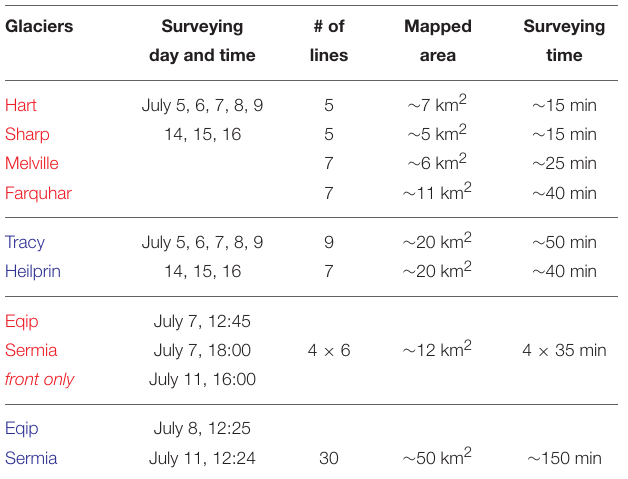
TABLE 2 | Details of red and blue missions operated in 2017 in the Inglefield Bredning ( Figure 1 ) and in 2018 at Eqip Sermia glacier ( Figure 2 ). Glaciers Surveying # of Mapped Surveying day and time